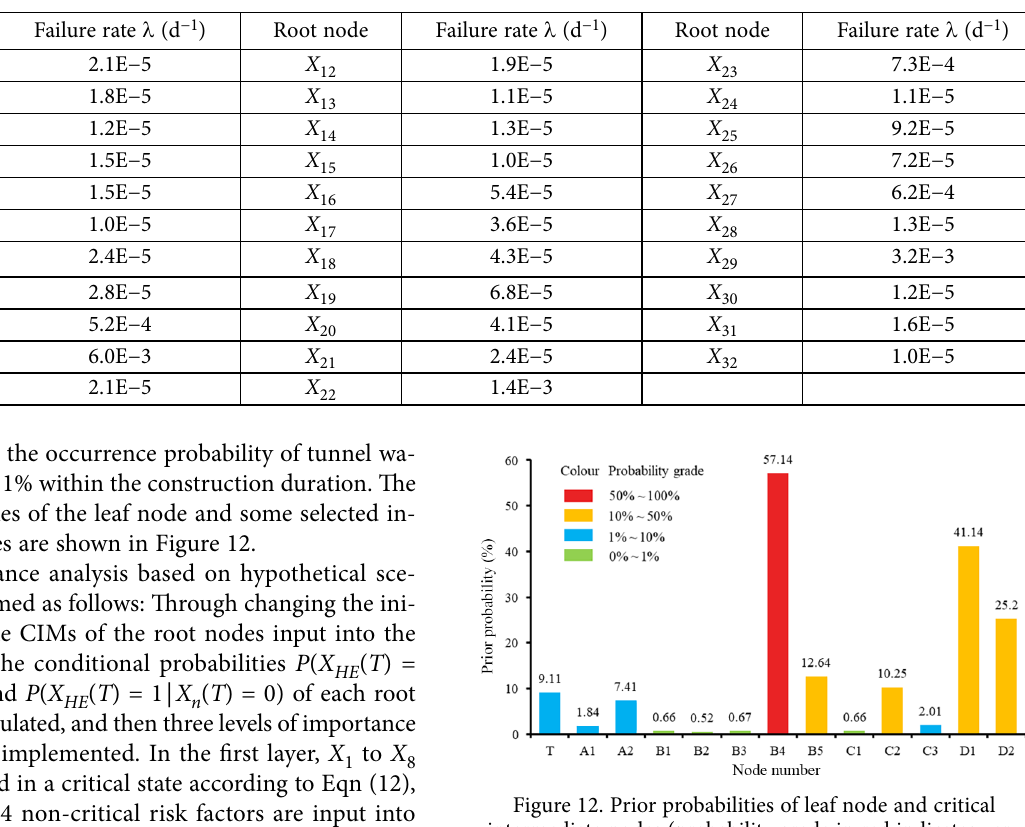
Table 19. Failure rate estimations of root nodes